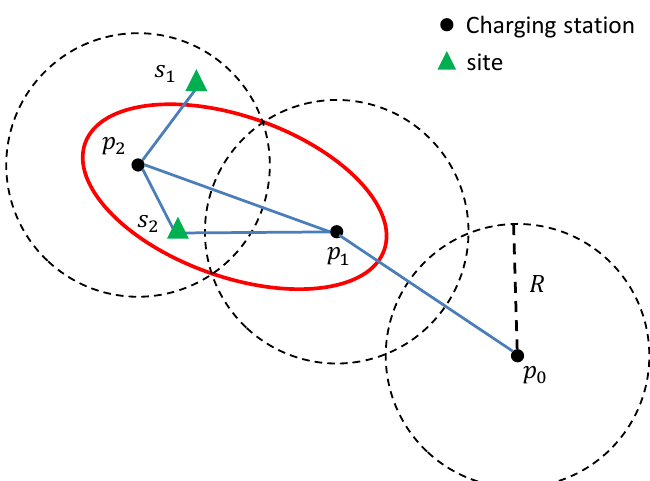
Figure 2. Illustrative example of the connections between site nodes and charging station nodes. Al- though both s 1 and s 2 are located within the circle centred at p 2 , s 1 connects with p 2 but not p 1 , while s 2 connects with both p 1 and p 2 . This is because | p 1 , s 1 | + | s 1 , p 2 | > 2 R , while | p 1 , s 2 | + | s 2 , p 2 | ≤ 2 R